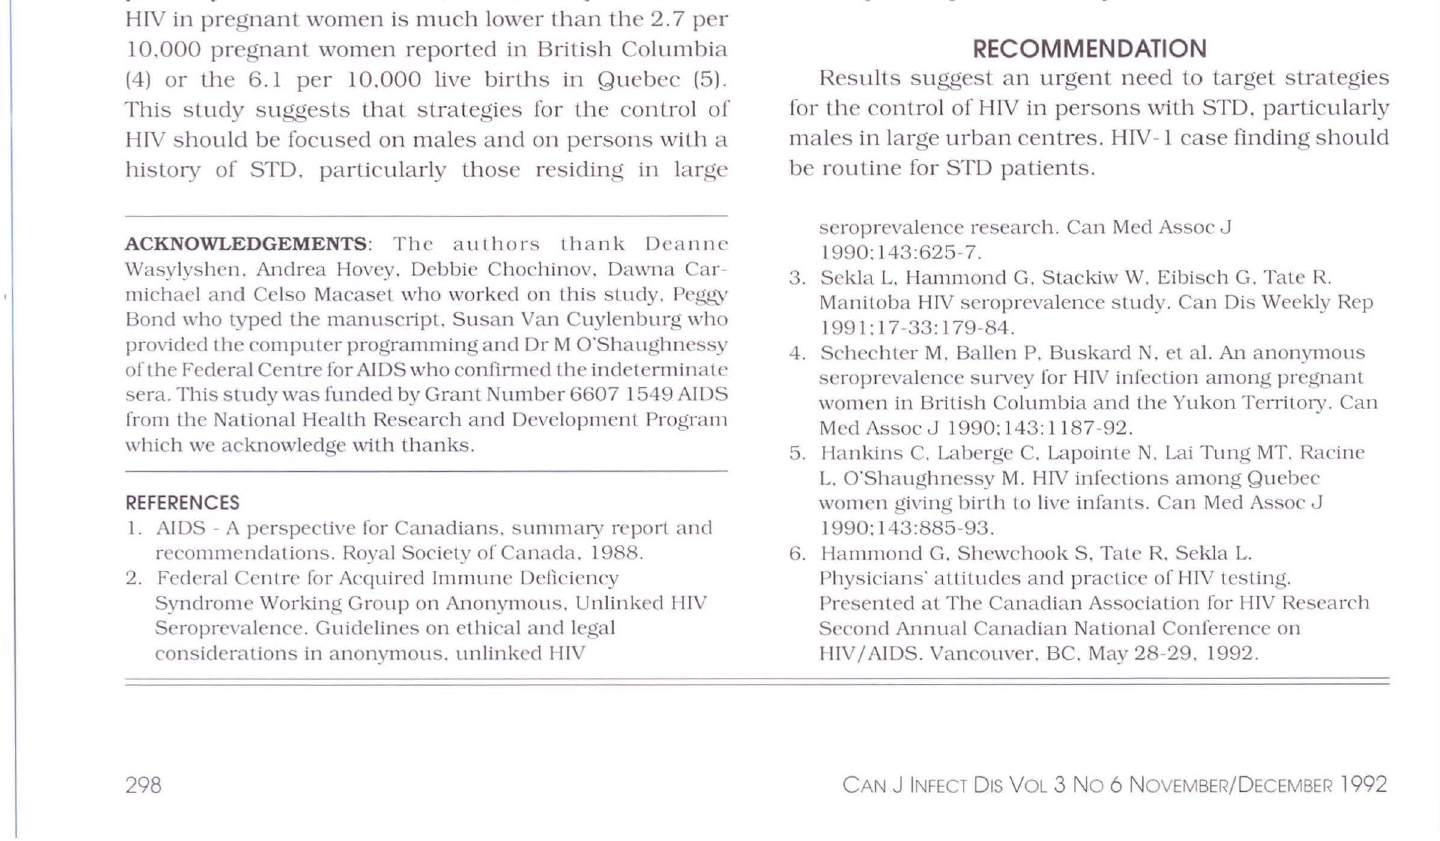
urban centres. Of U1e ll l positive males in the STD category. 95 (85.5%) resided in Winnipeg. A number of U1ese HN-posilive males may have been id ntified by Manitoba's serodiagnostic program. The design of U1e serosurvey does not allow any personal identification. so the number of new seropositives could not be deter mined. In U1e STD category. more males were tested in Winnipeg than out ide of Winnipeg. and U1ere were more positive in (versus outside oO Winnipeg: 1.68% positivity in Winnipeg (54 positives out of 3203 tested) and 0.58% outside of Winnipeg (ll positives out of 1877 tested). lL is important to note that clinics at tended by high risk clientele are mainly located in Winnipeg. CUnicians s hould think of HN in any pa tient wilh a past or present history of